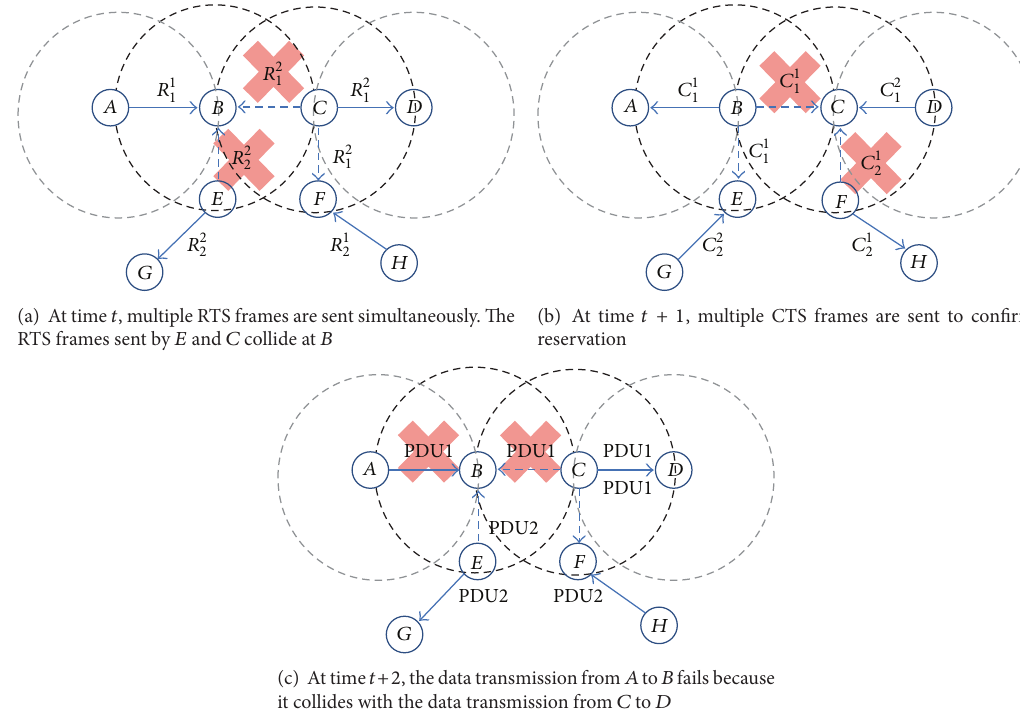
Figure 5: An LET4 takes place because local information cannot reflect the network state